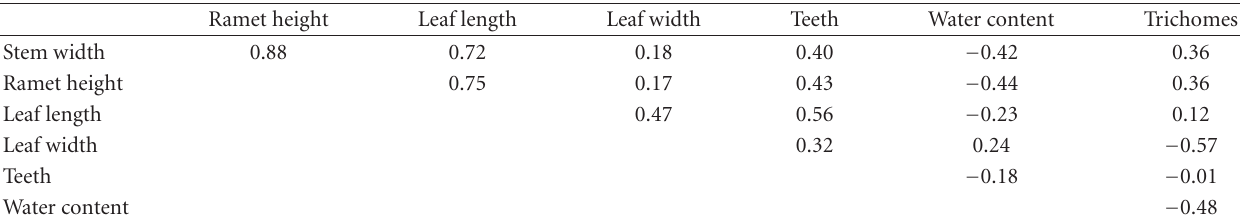
Table 2: Correlations among morphological variables measured for S. altissima and S. gigantea.